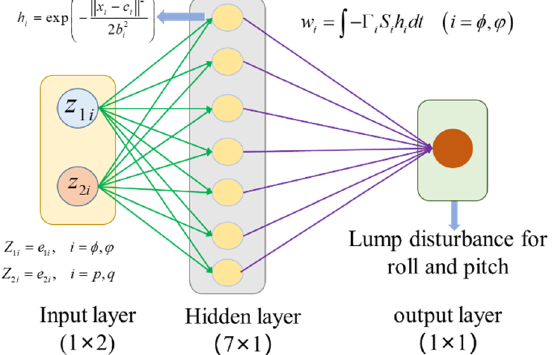
Figure 4. The RBFNN for the lumped disturbance of the roll angle controller and pitch angle con- troller.